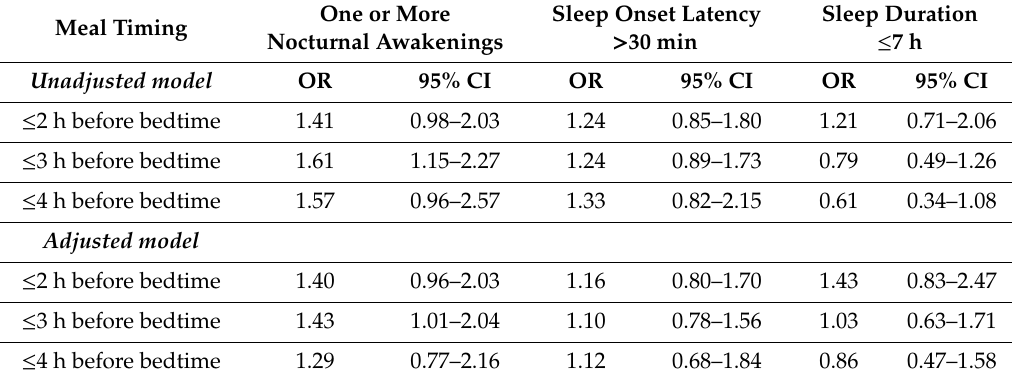
Table A2. Association between meal timing at di ff erent cut-o ff points and sleep parameters with and without adjustment for covariates by logistic regression analysis ( N =